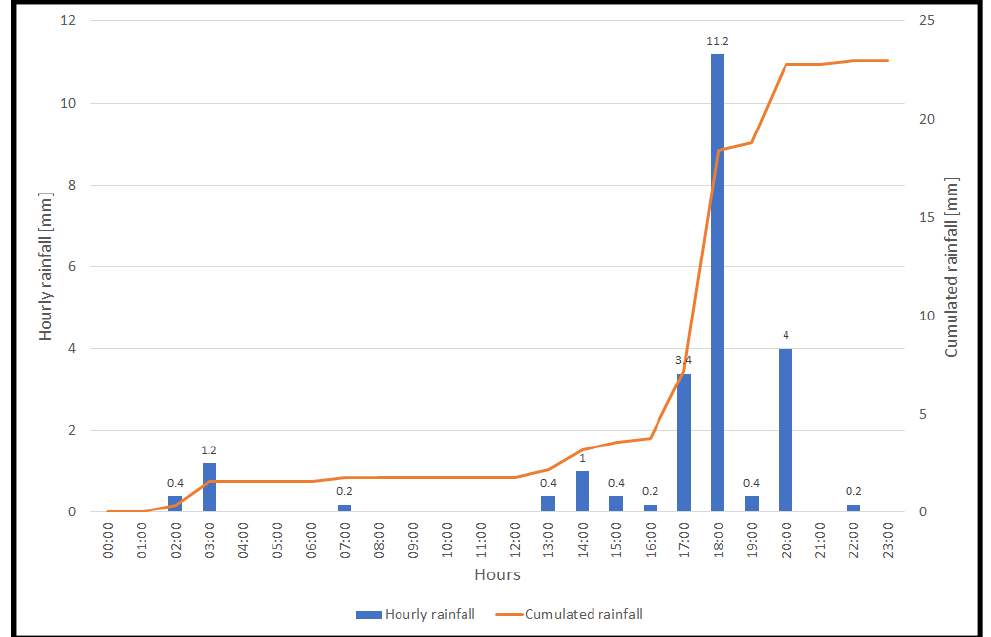
Figure 17. Hourly and cumulated rainfall recorded by Prarotto raingauge on 7 June 2018. In Figure 18 rainfall event responsible for debris flow occurrence (in red) is compared with rainfall events occurred in preceding months.